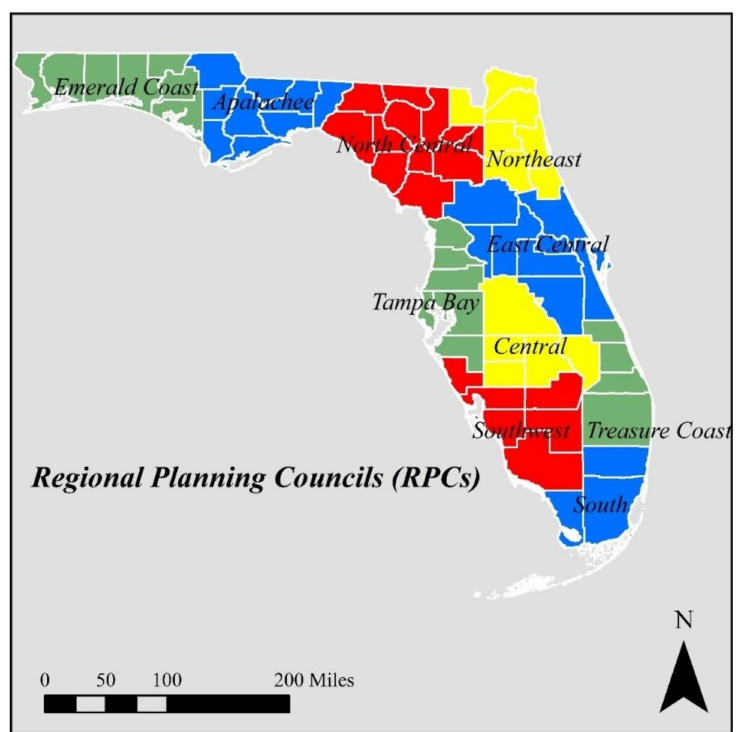
Figure 6. Florida’s 10 regional planning councils